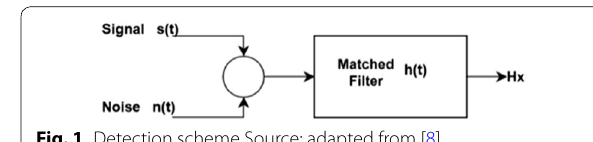
Fig. 1 Detection scheme Source: adapted from